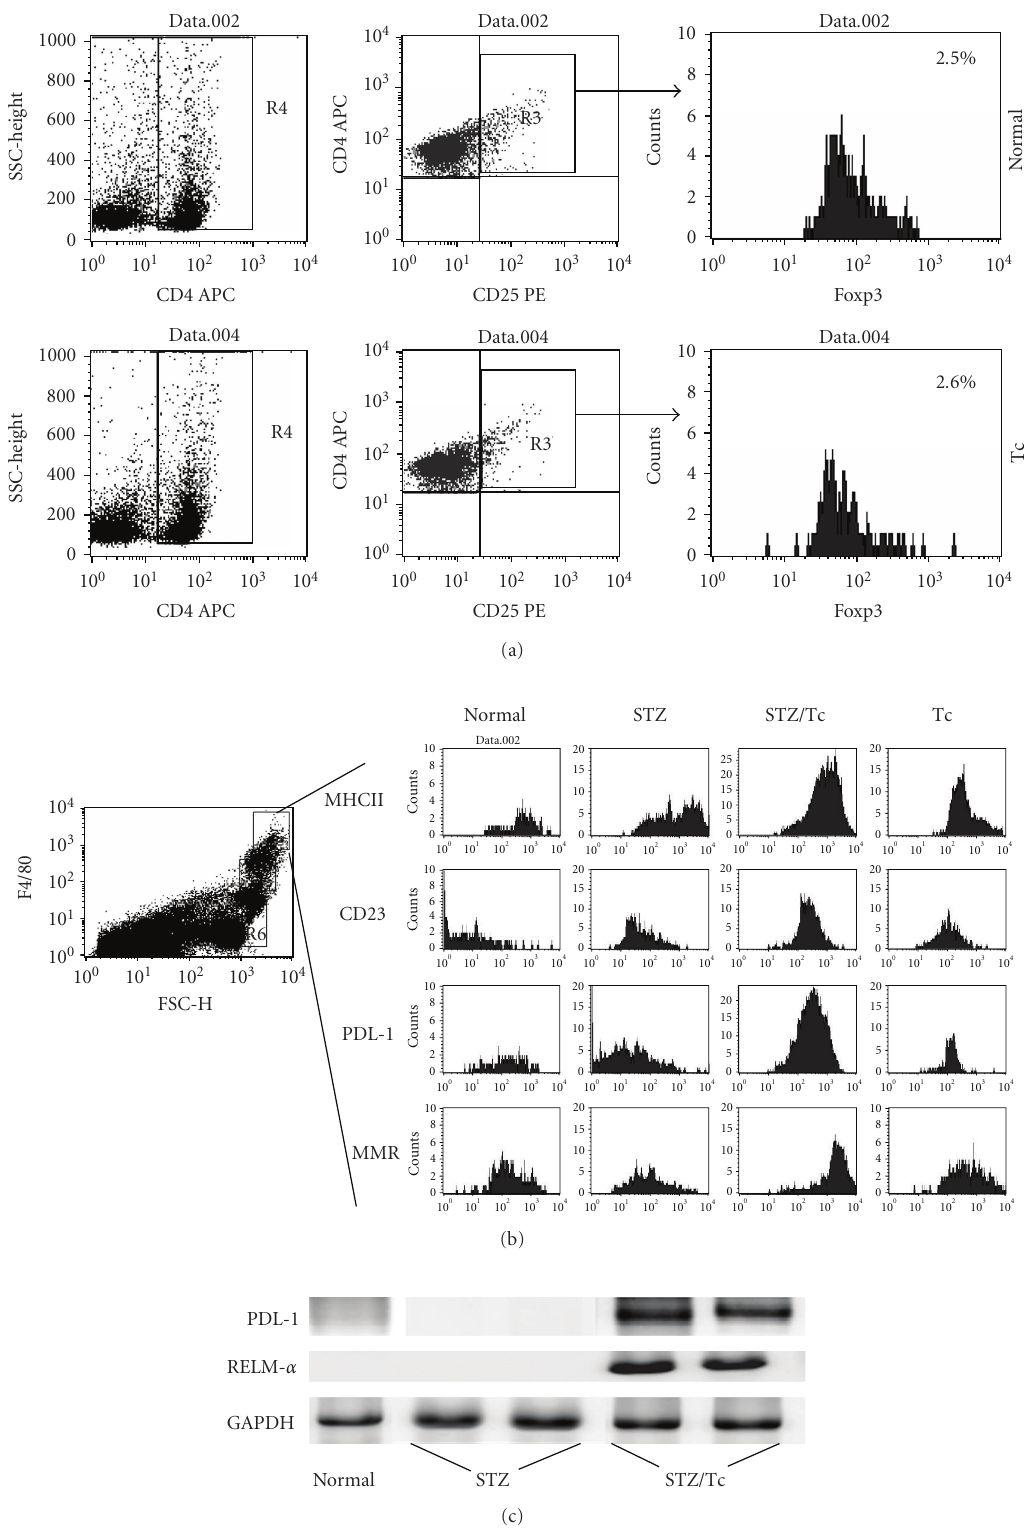
Figure 6: Flow cytometry analysis for the detection of regulatory T cells and alternatively activated macrophages. (a) Mesenteric lymph nodes from BALB/c mice were processed and cells were staining for Treg cell detection with anti-CD4, CD25, and Foxp3 (Tregs kit, Biolegend). (b) Peritoneal exudates cells stained with conjugated anti-F480, CD23, MR, PDL1, and MHCII and analyzed by flow cytometry. (c) RT-PCR analysis of PDL-1, RELM- α , and GAPDH in macrophages from uninfected and T.crassiceps -infected BALB/c